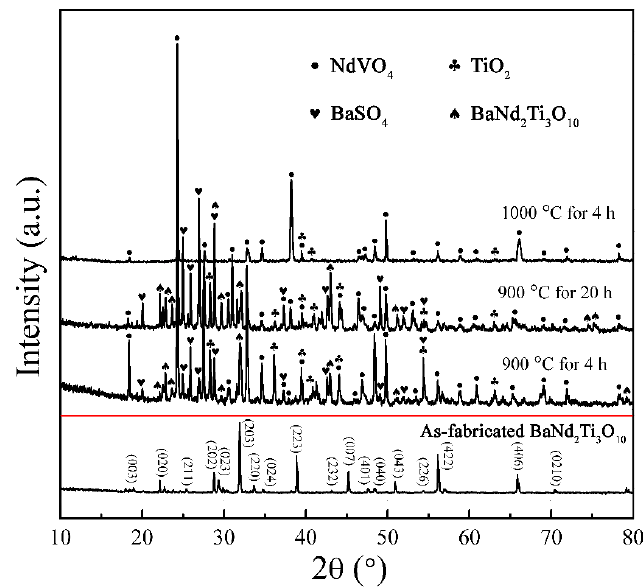
Figure 2. XRD patterns of the as-fabricated BaNd 2 Ti 3 O 10 pellet and the pellets after hot corrosion in Na 2 SO 4 + V 2 O 5 salt at 900 °C for 4 h and 20 h, and 1000 °C for 4 h.